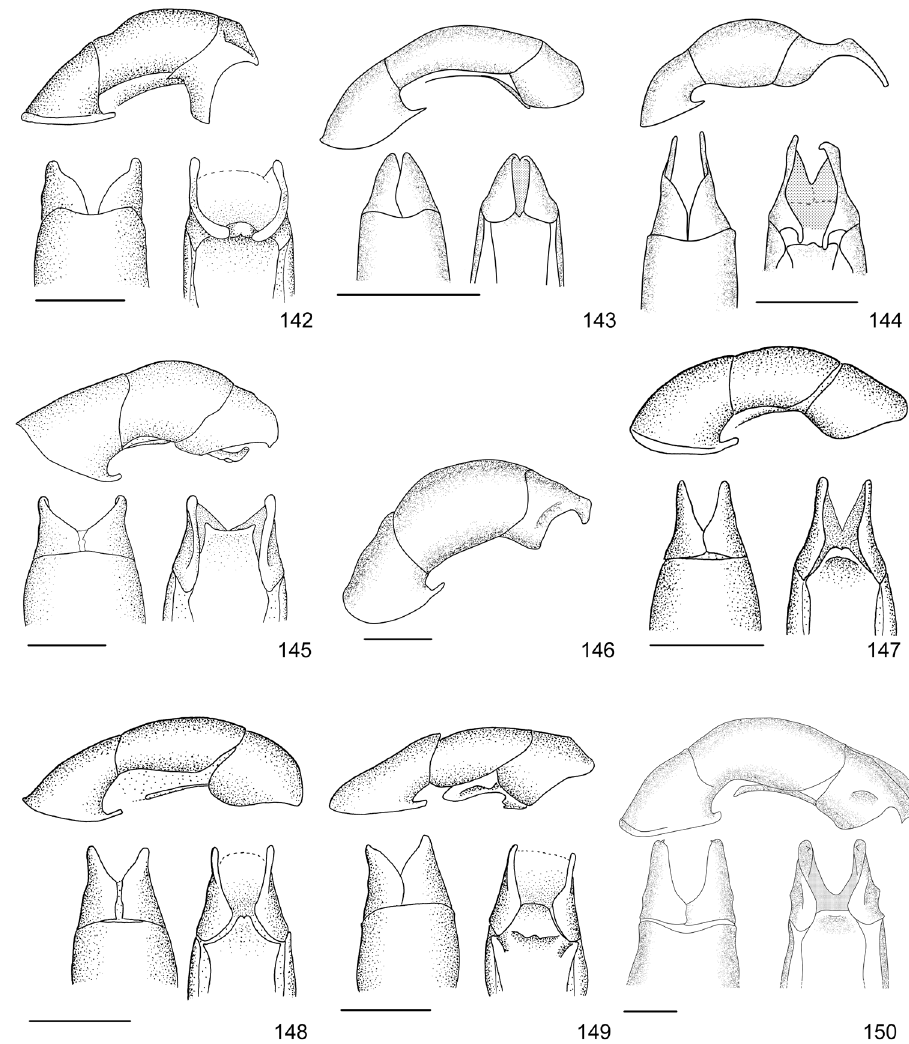
Figures 142–150. Shape of aedeagus, lateral view (top), dorsal view (bottom left), ventral view (bottom right). 142 Anomala hiata (Estación Pittier, Puntarenas, MNCR) 143 A. histrionella (Bahía Santa Elena, Guanacaste, MNCR) 144 A. hoppi (Las Cruces, Puntarenas, MNCR) 145 A. inbio (Volcán Tenorio, Guanacaste, CEUA) 146 A. jansoni (Monte Rotondo, Costa Rica, MNHUB) 147 A. latifalculata (Zona Protectora Cerros de la Carpintera, Cartago, MNCR) 148 A. leopardina (Finca Cafrosa, Puntarenas, MNCR) 149 A. levicollis (Cerro Montezuma, Alajuela, CEUA) 150 A. limon (Estación Hitoy Cerere, Limón, MNCR). Scale bars: 1 mm. Figs 146, 150 modified from Filippini et al. (2015b); Figs 142, 145, 147–149 from Filippini et al.